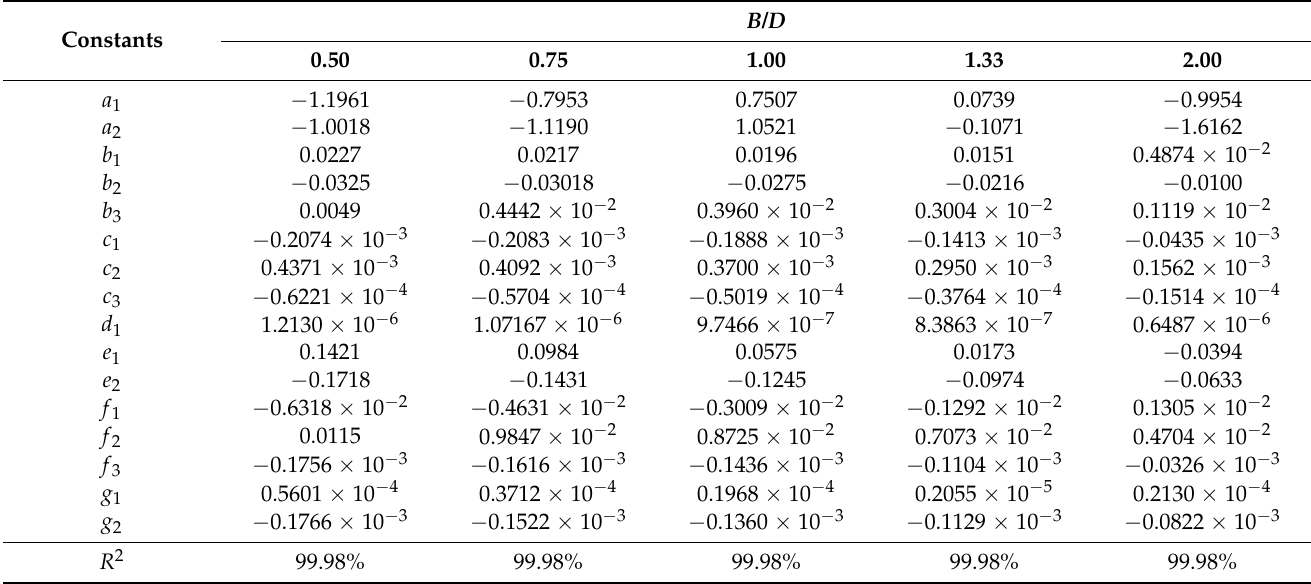
Table 2. Optimal value of the constants for the design equation ( B / D = 0.5 to